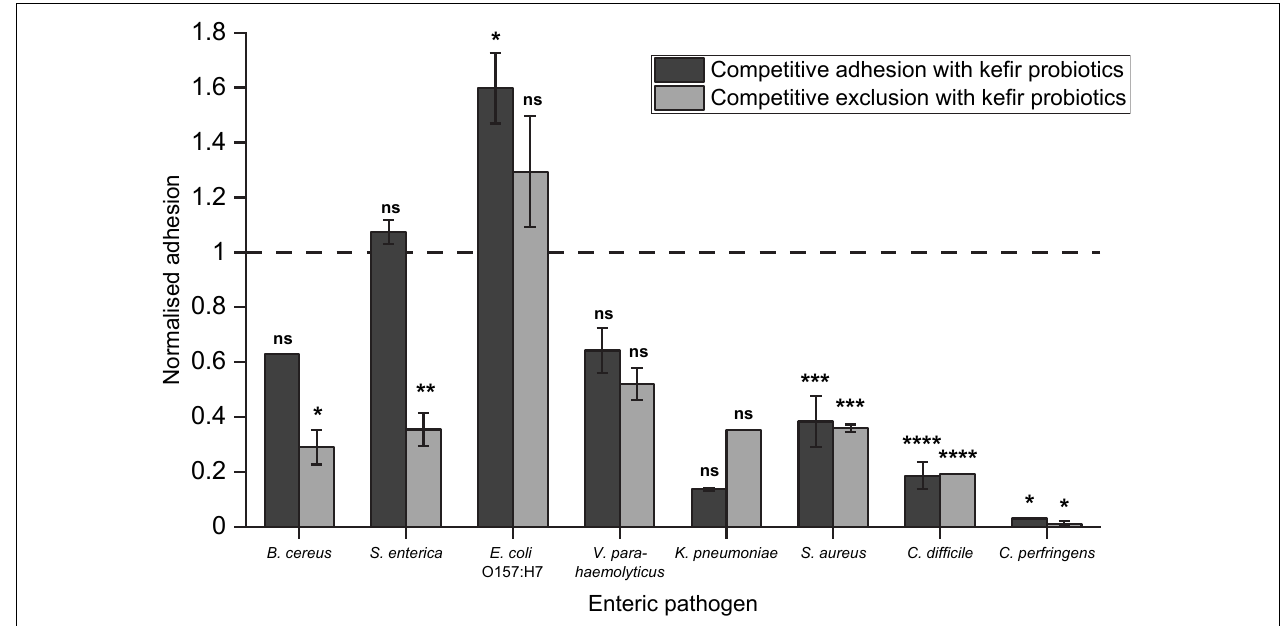
FIGURE 2 | Ability of kefir probiotics to: (a) compete with enteric pathogens for adhesion sites (referred to as competitive exclusion) or (b) exclude adhesion of enteric pathogens when introduced before exposure to the pathogen (referred to as competitive exclusion). Normalized adhesion of 1 indicates that the number of pathogens adhered in competitive adhesion/exclusion with kefir probiotics, was the same as when the pathogens were added alone. Data are presented as an average of duplicates with standard deviation bars. Letters on bars were determined by Dunnett test based on a pairwise-comparison with pathogen-only treatment (refer to Supplementary Table 2 for statistical data). Letters on bars were based on * p < 0.05, ** p < 0.01, *** p < 0.001, **** p < 0.0001, ns – no significant